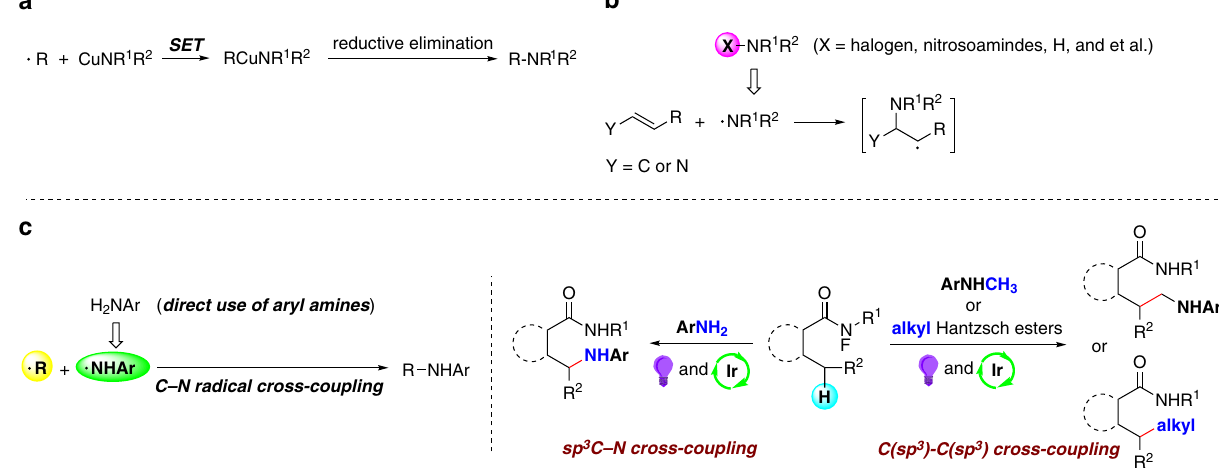
Fig. 1 sp 3 C – N bond formations with N-center radicals. a Cu-catalyzed radical sp 3 C – N cross-couplings 6 – 8 . b Addition reactions between N-center radicals and alkenes (enamines) 9 . c This work: sp 3 C – N cross-coupling between alkyl radical and N-center radical. X = halogen, nitrosoamides, H, and so on. Y = C or